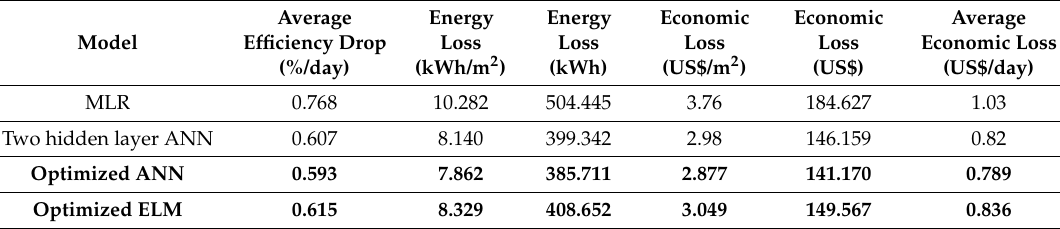
Table 2. Losses and dust effect using all investigated prediction models for the whole study period ( 𝑛 = 179 days).